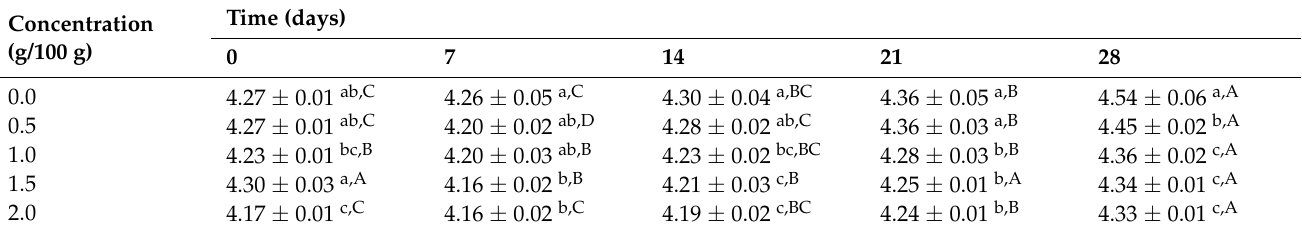
Table 1. pH values of sweetened plain whole-fat yogurts with addition of jabuticaba skin powdered extract at different concentration levels during refrigerated